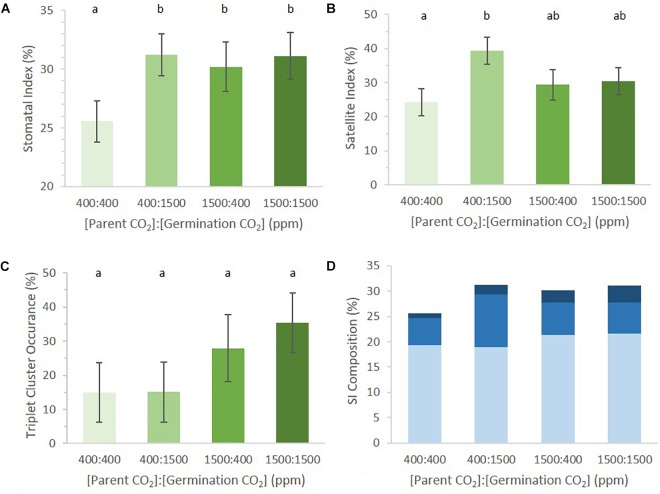
Abaxial stomatal patterning in cotyledons from seed set and germinated in differing p[CO2] environments (error bars, s.e.m.; n = 10). (A) SI was greater in all conditions where p[CO2] was elevated (p = 0.04). (B) SatI across the four treatments. (C) Proportion of satellite stomata that made a third satellite was higher in 1500 ppm parental environment than 400 ppm parental environment (p = 0.076). (D) Composition breakdown of all stomata. Light blue indicates percentage basal-pathway stomata, medium blue indicates percentage satellite stomata, and dark blue indicates percentage triplet satellite stomata. Letters indicate similarity based on a p-value of 0.05 for independent pair-wise comparisons.